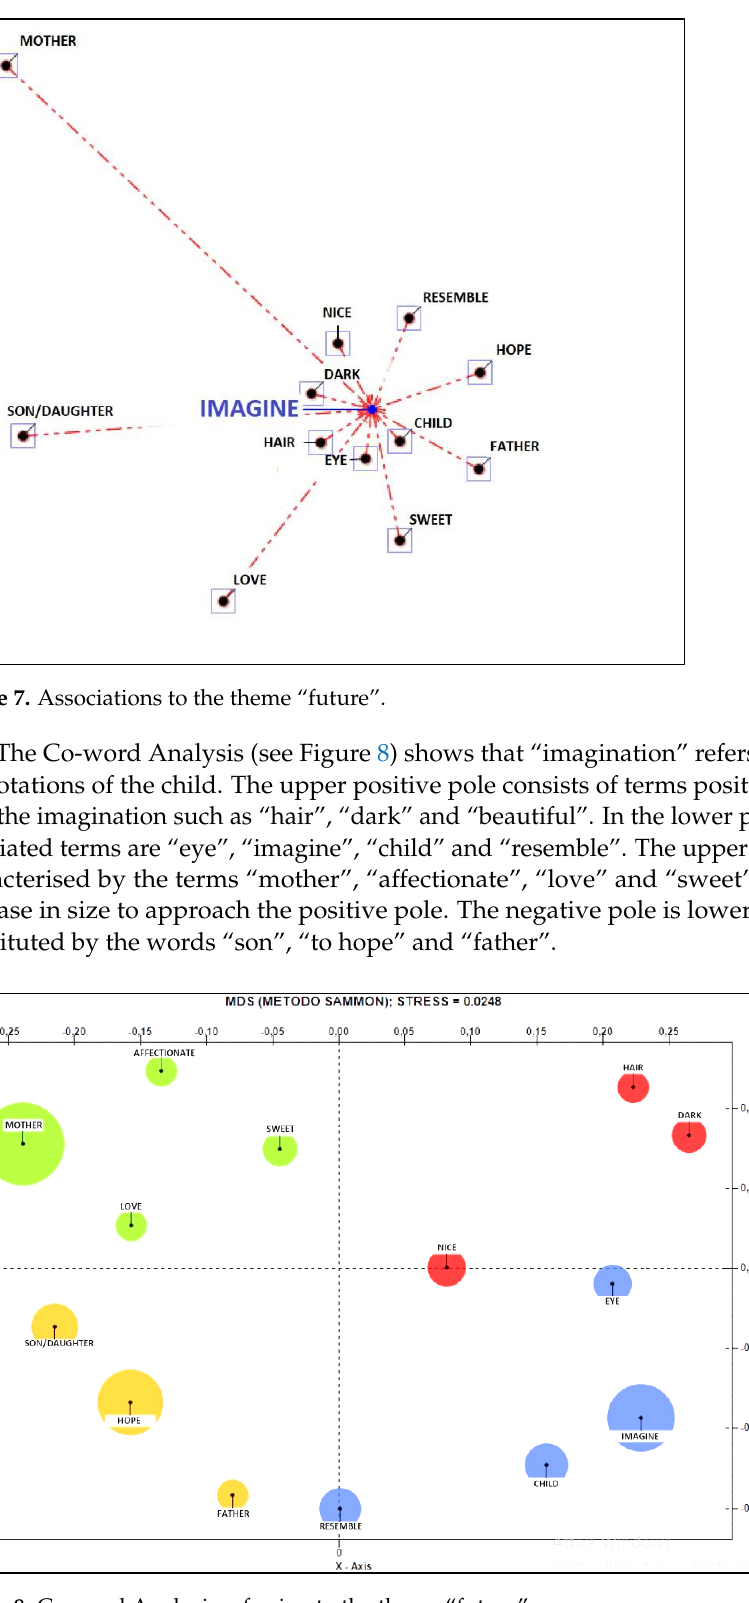
Figure 8. Co- word Analysis referring to the theme “future”. Figure 8. Co-word Analysis referring to the theme